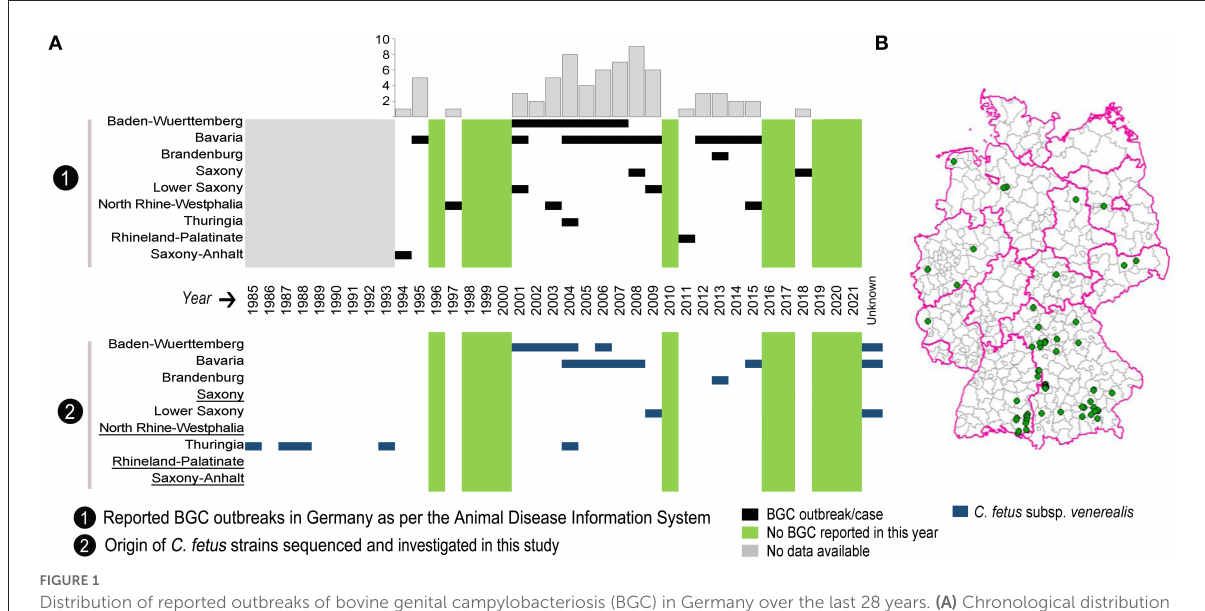
FIGURE1 Distribution of reported outbreaks of bovine genital campylobacteriosis (BGC) in Germany over the last 28 years. (A) Chronological distribution of the reported BGC outbreaks per German state with the annual cumulative number of outbreaks in the bar chart. The bottom panel shows the temporal distribution of C. fetus subsp. venerealis strains examined by whole-genome sequencing in each state. Underlined German states indicate that no strains were available for sequencing. (B) Map showing the geographical distribution of reported BGC outbreaks across